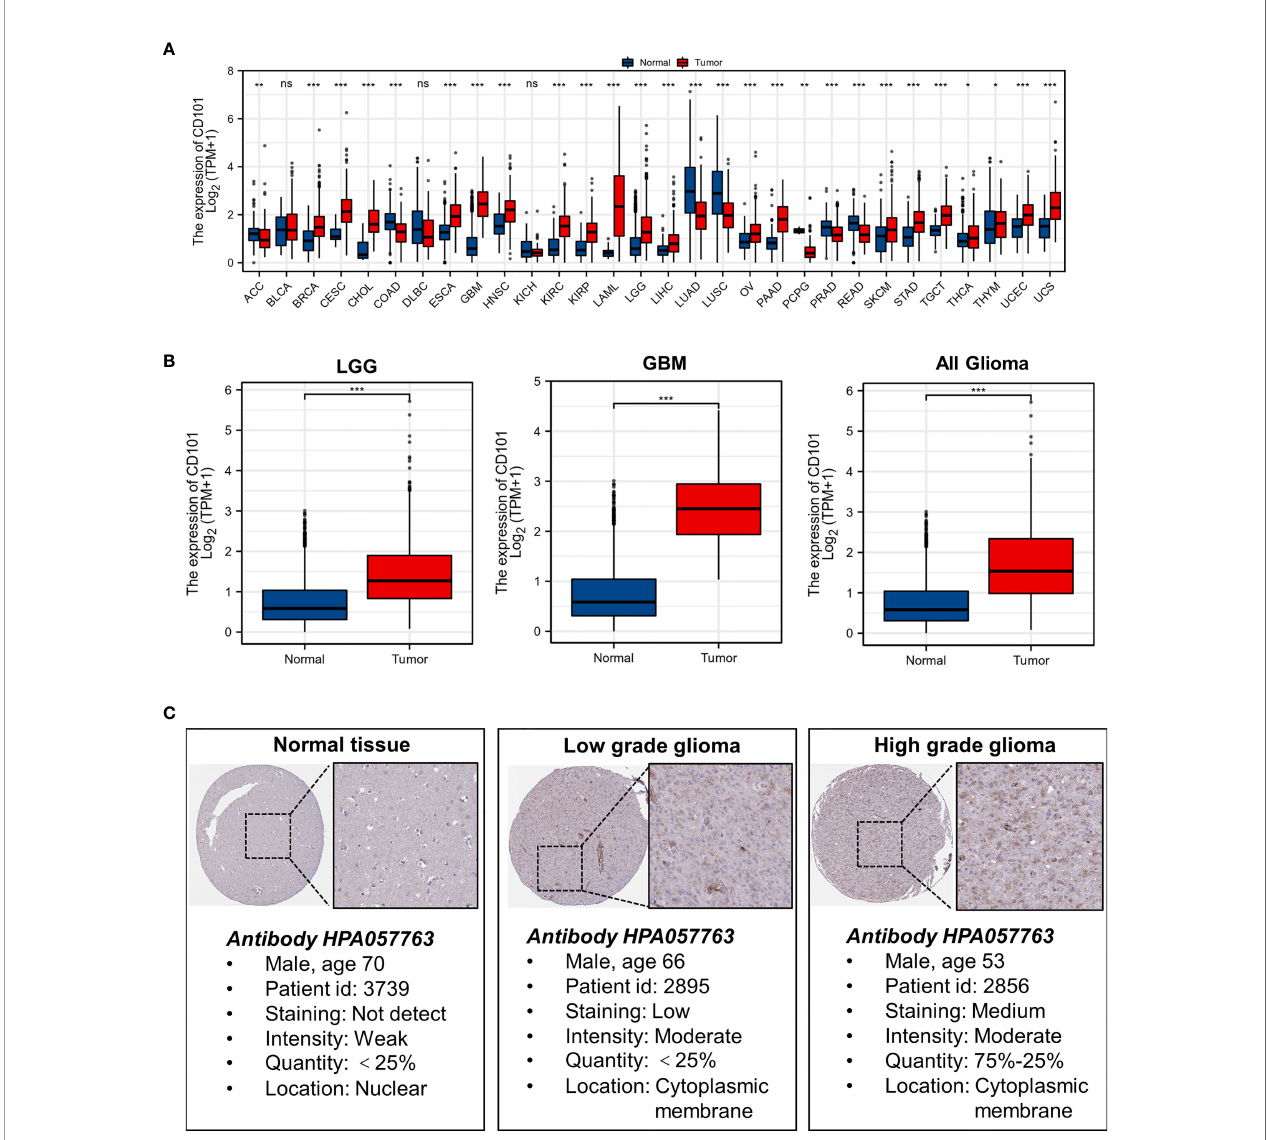
FIGURE 1 | Expression level of gene CD101 in tumors and normal tissues. (A) CD101 expression in TCGA tumors and normal tissues with the GTEx database as controls. (B) CD101 expression in TCGA gliomas and normal tissues with the GTEx database as controls. (C) Expression of the CD101 protein was visualized by immunohistochemistry via the HPA database (ns, p ≥ 0.05, * p < 0.05, ** p < 0.01, *** p <